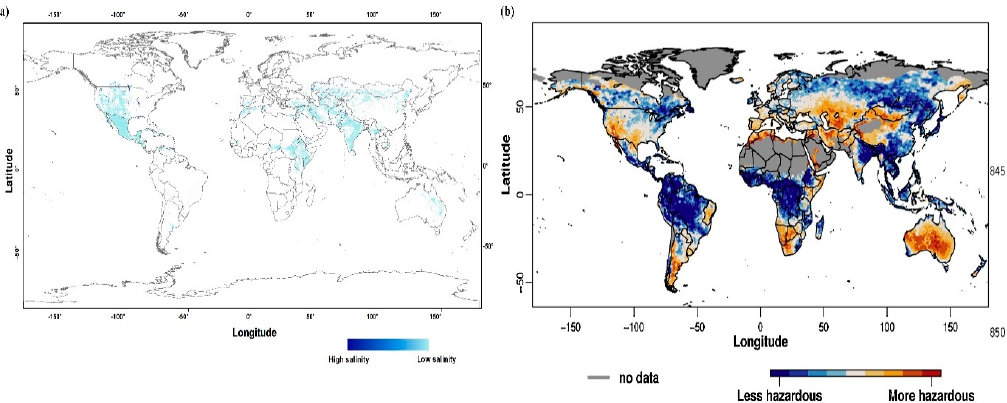
Figure 1. Global distribution of drought and salinity. In panel ( a ), the global map of soil salinity change is shown [10], while in panel ( b ) the global map of drought hazard [28] is shown. Global soil salinity map was extracted from [10] and then transformed to the plate carr é e projection by